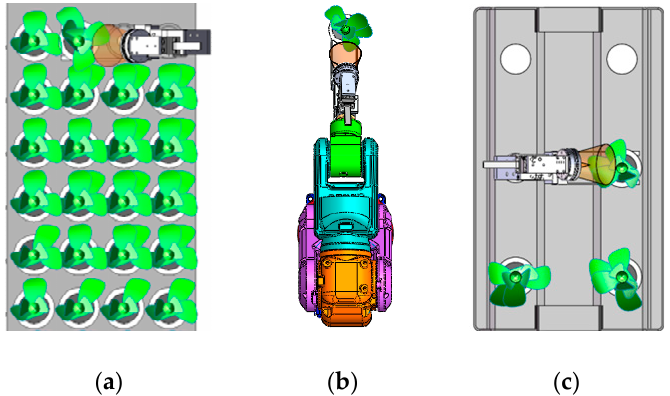
Figure 14. Single-claw transplanting actuator work plan. ( a ) Taking seedlings; ( b ) detection; ( c ) transplanting.